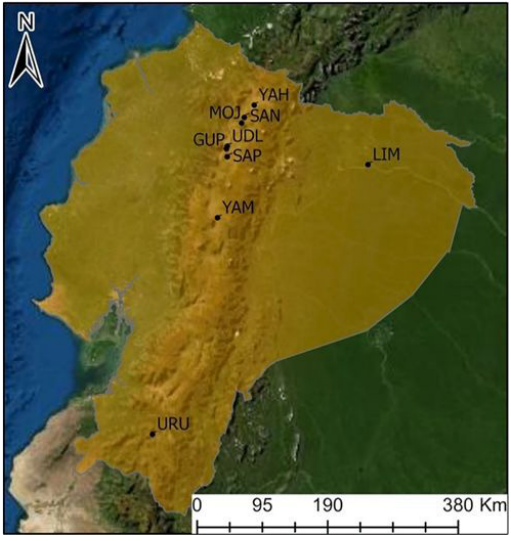
Figure 1. Map of Ecuador showing the sampling